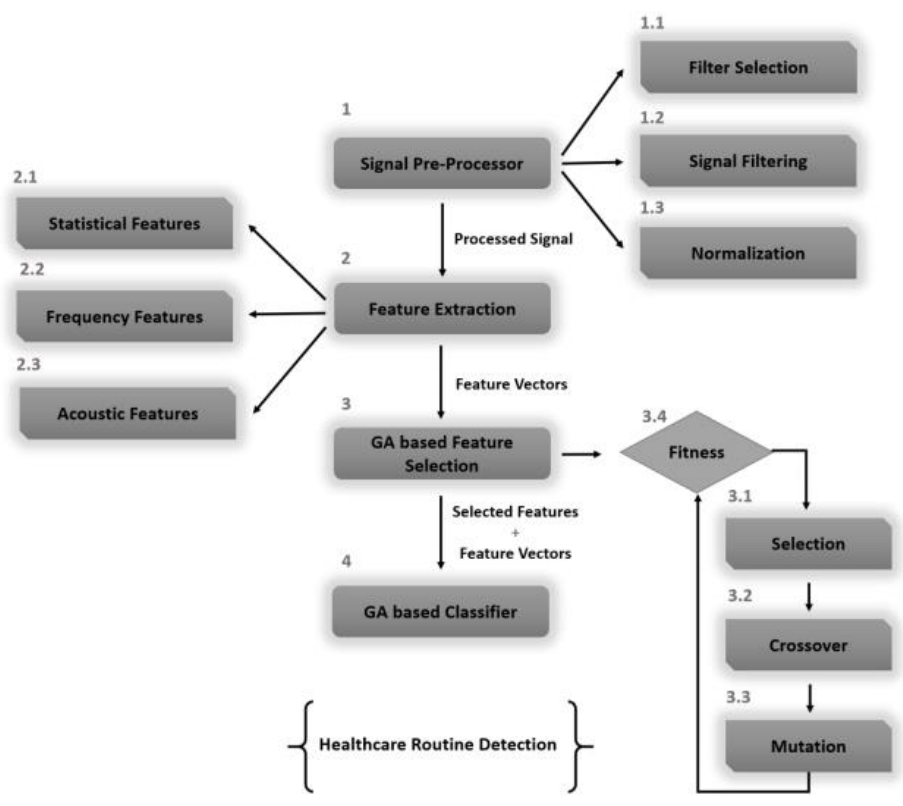
Figure 9. The proposed reweighted genetic algorithm for recognizing human motion from inertial- based